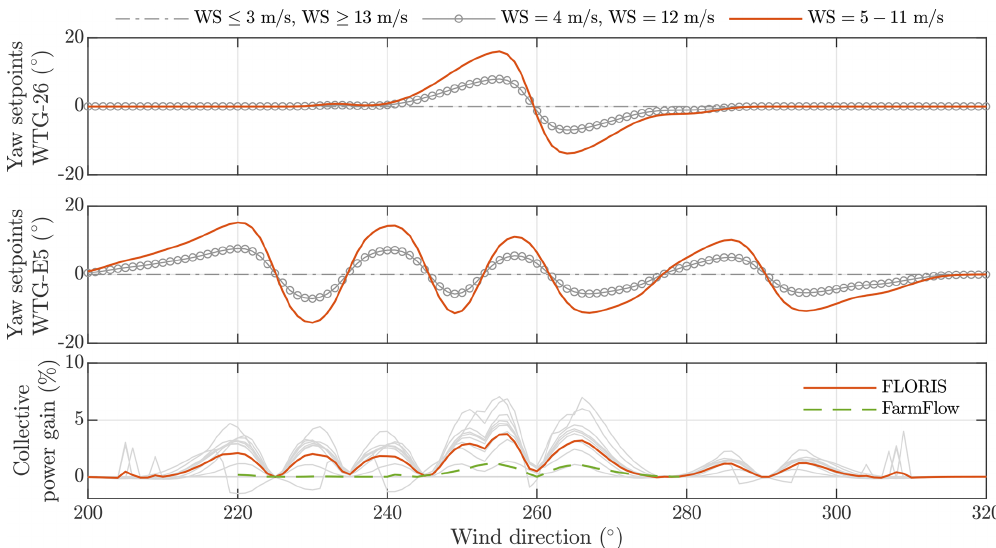
Figure A1. The optimal turbine yaw angle setpoints for WTG 26 and E5 for a freestream turbulence intensity of 13.5%. The averaged collective power gain of WTG 26, WTG E5, and the downstream machine (WTG 10, 11, 12, or 31) is shown as the solid orange line (FLORIS) and the dashed green line (FarmFlow) in the bottom plot. The gray lines therein represent the predicted gains for one wind speed by FLORIS.